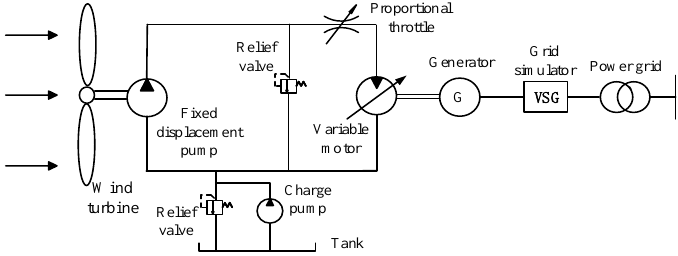
Figure 1. Diagram of the principle of operation of the hydraulic system for hydraulic wind turbines (HWT).